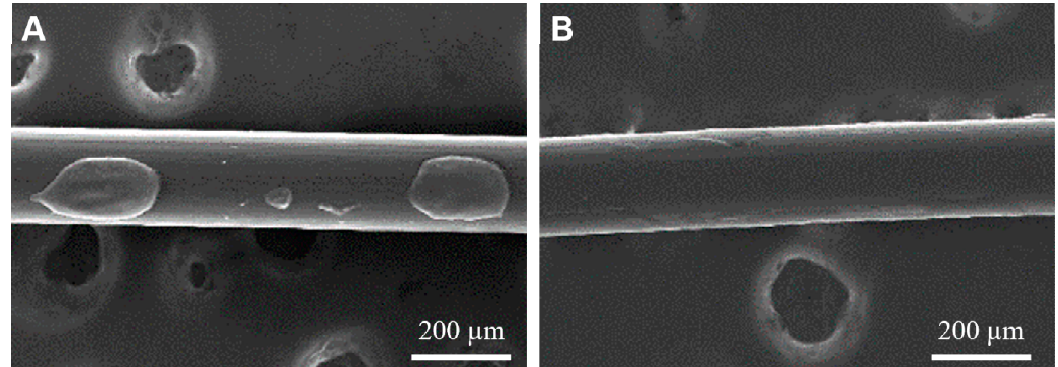
Figure 4. Plasma treatment of PP substrates for 10 min improves macroscopic pCD coating uniformity on wells of a PP 24-well plate. This remained true regardless of the amount of HDI crosslinker added.